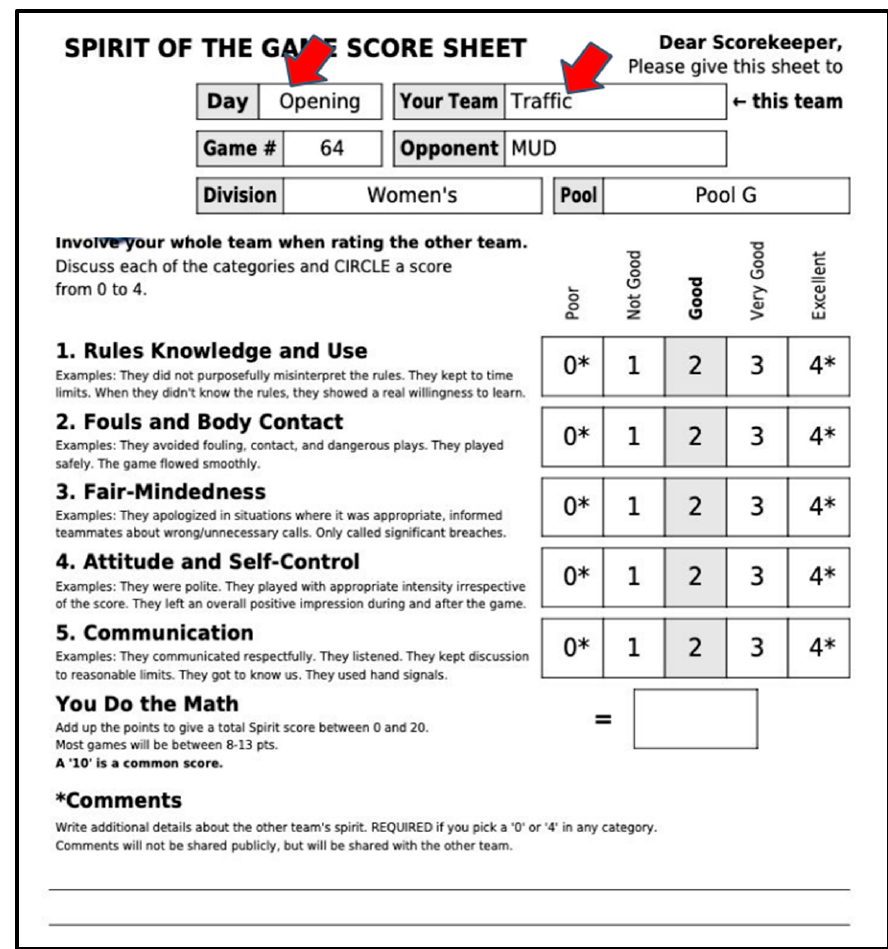
Figure 2. SOTG game score sheet made up of five questions addressing the following domains: (1) Knowledge and use of the rules; (2) Fouls and body contact; (3) Fair-mindedness; (4) Positive attitude and self-control; (5) Communication. Answers were provided on a 5-point Likert scale (0 = Poor; 1 = Not Good; 2 = Good; 3 = Very Good; 4 = Excellent). After each game, players rated if the other team was “better than,” “worse than,” or “the same as” a rivals in a regular game, using the anchor “Good” as a baseline for comparison. The final SOTG score is the sum scoring/marking and may vary between 0 and 20, where a score of 10 is considered normal, good Spirit.